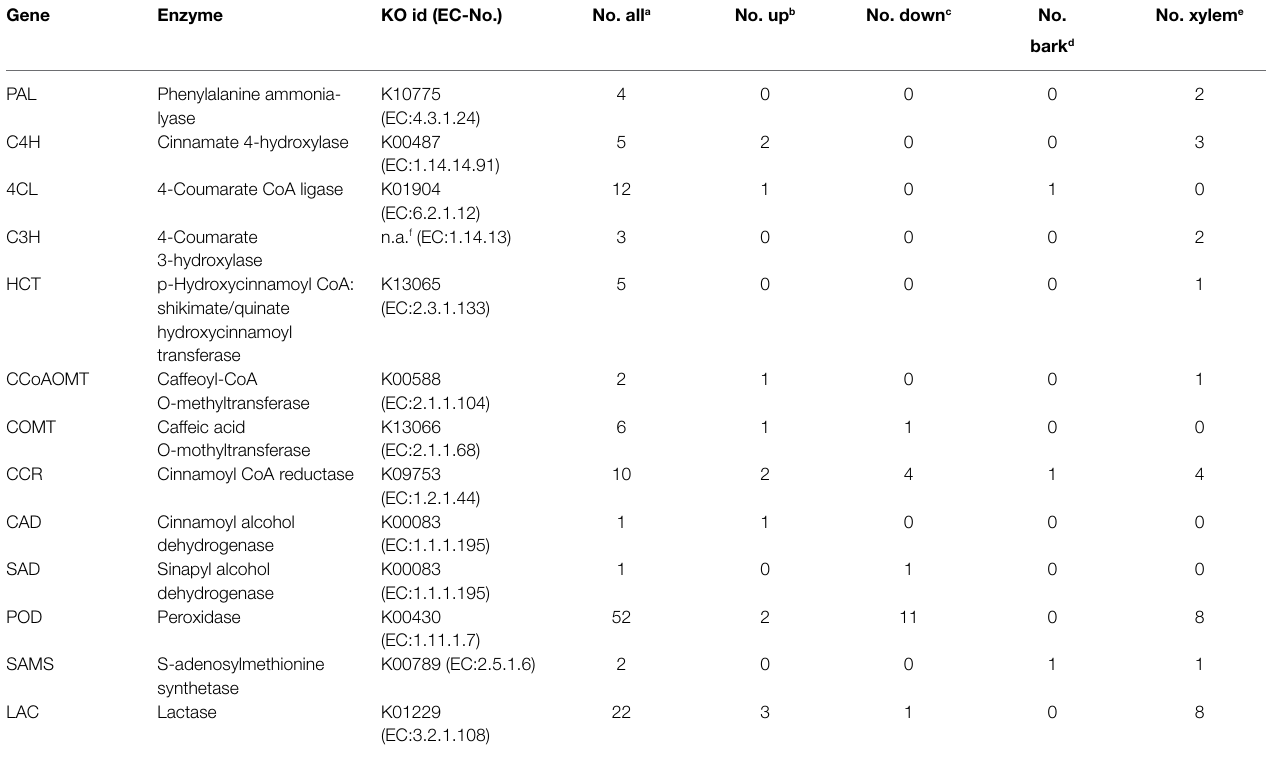
TABLE 5 | Candidate differentially expressed genes involved in lignin biosynthesis-related metabolism. Gene Enzyme KO id (EC-No.) No. all a No. up b No. down c No.